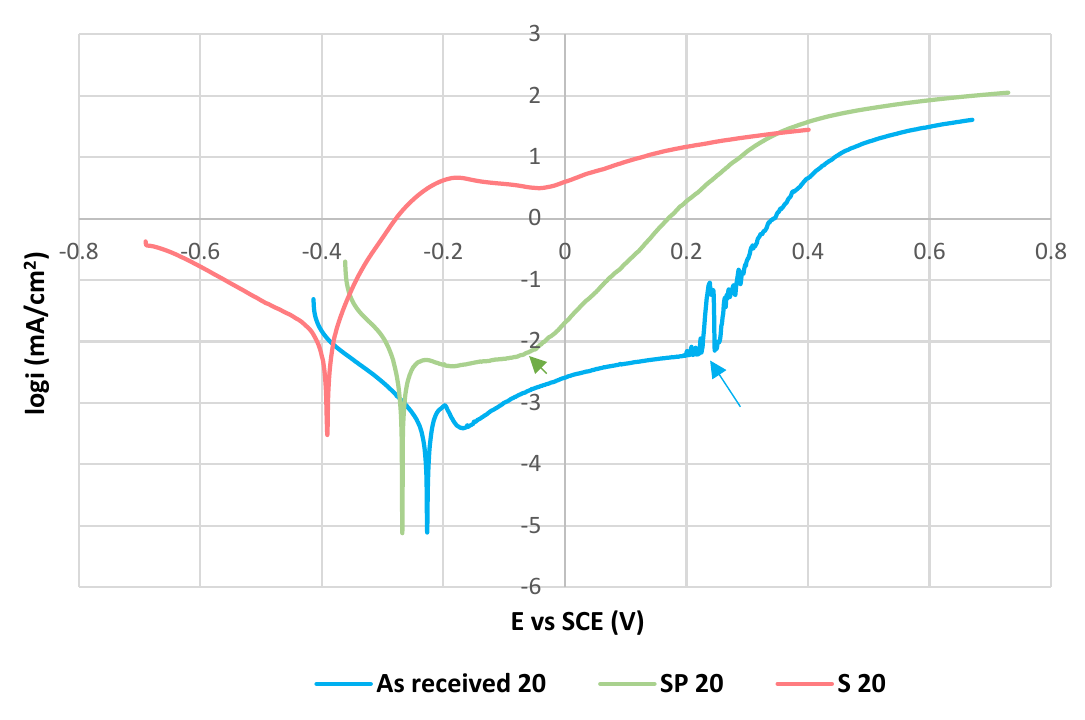
Figure 3. Potentiodynamic polarization curves for tested specimens at 20 ± 3 °C. The pitting poten- tials E p related to the as received 20 and SP 20 curves are marked by the arrows.